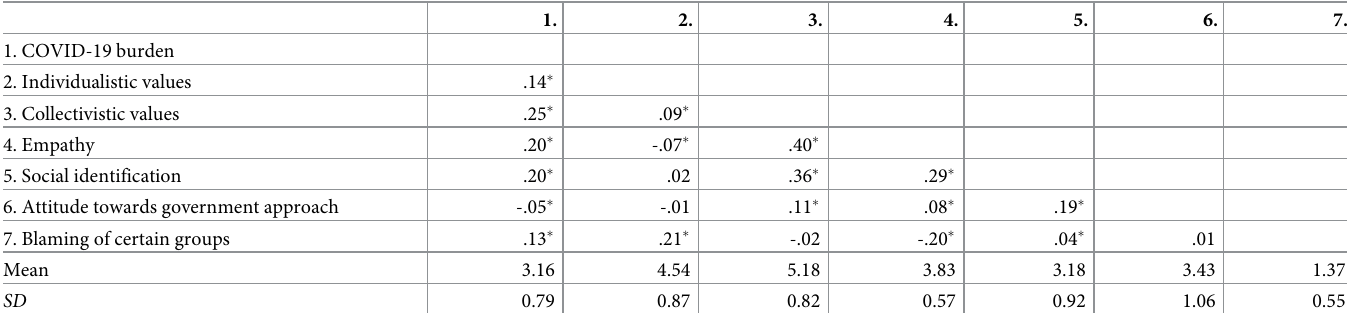
Table 1. Descriptive statistics of and correlations between the study variables.